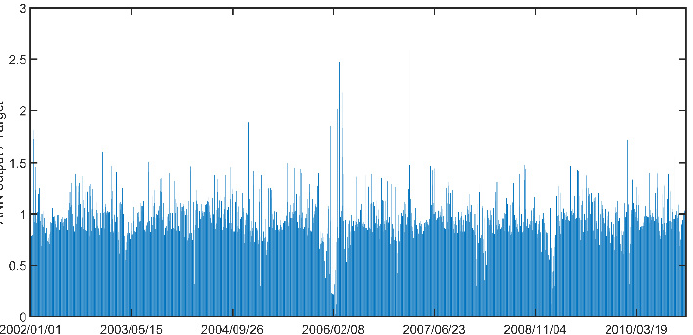
Figure 5. Performance of ANN in modeling Chl-a concentrations simulated by GLM-AED (Targets) in WLE from 2002 to 2010.